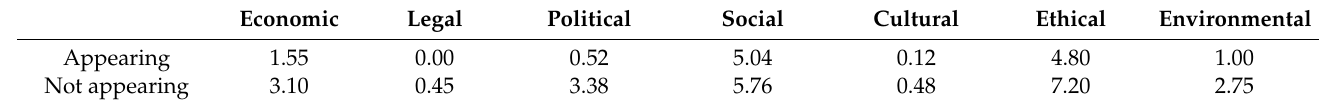
Table 6. Relative